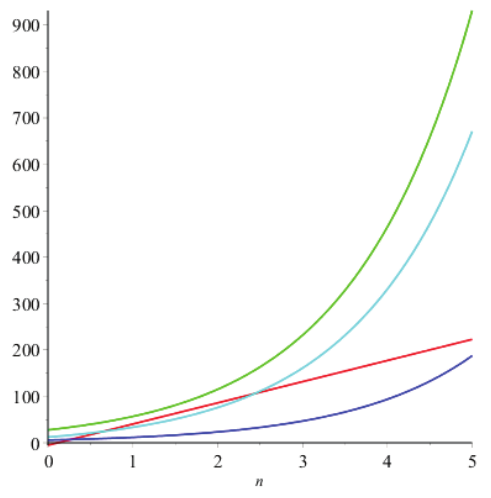
Figure 5: Correlation of Randic index with the boiling point of a selected set of alkanes.